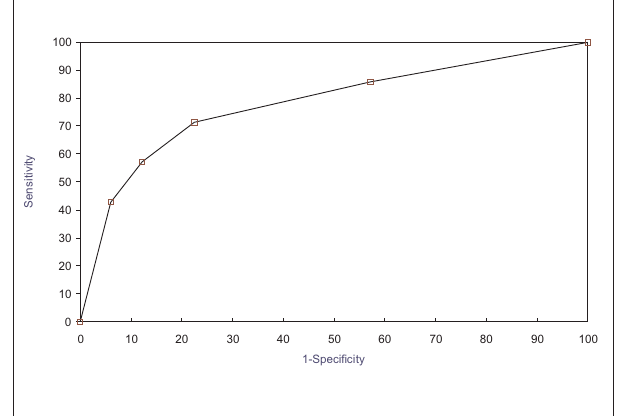
Figure 1) Receiver operator characteristic curve of Western blot analy- sis. Area under the curve = 0.77 (95% CI 0.58 to